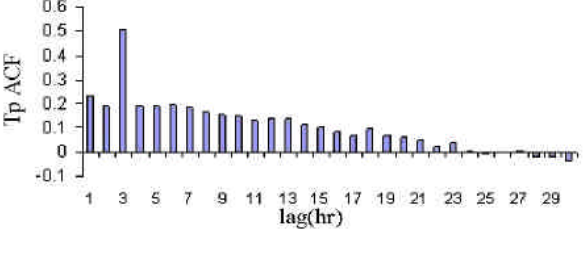
Fig. 15. Dominant wave period T p autocorrelation with 1-h time